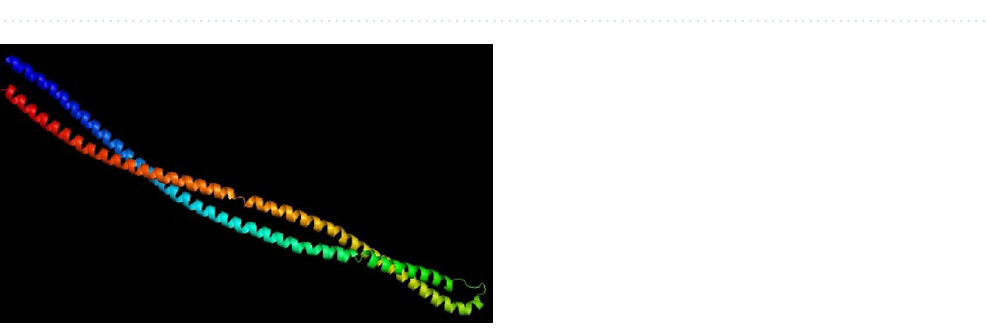
Figure 3. The 3D model of the final designed vaccine was obtained after homology modeling on